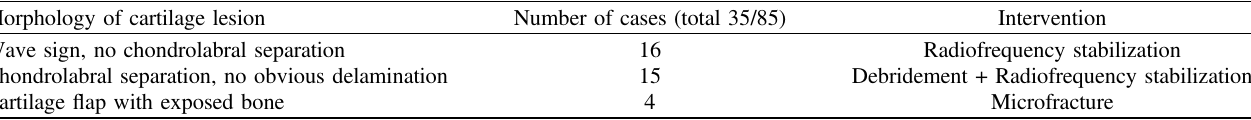
Table 2. Morphology of cartilage lesions encountered and the surgical intervention performed. Morphology of cartilage lesion